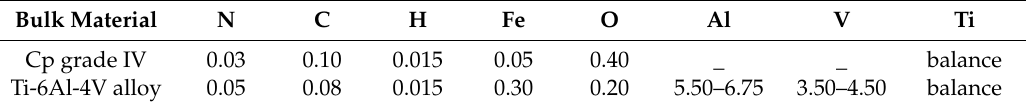
Table 1. Composition of cp grade IV Titanium and Titanium alloy. Weight